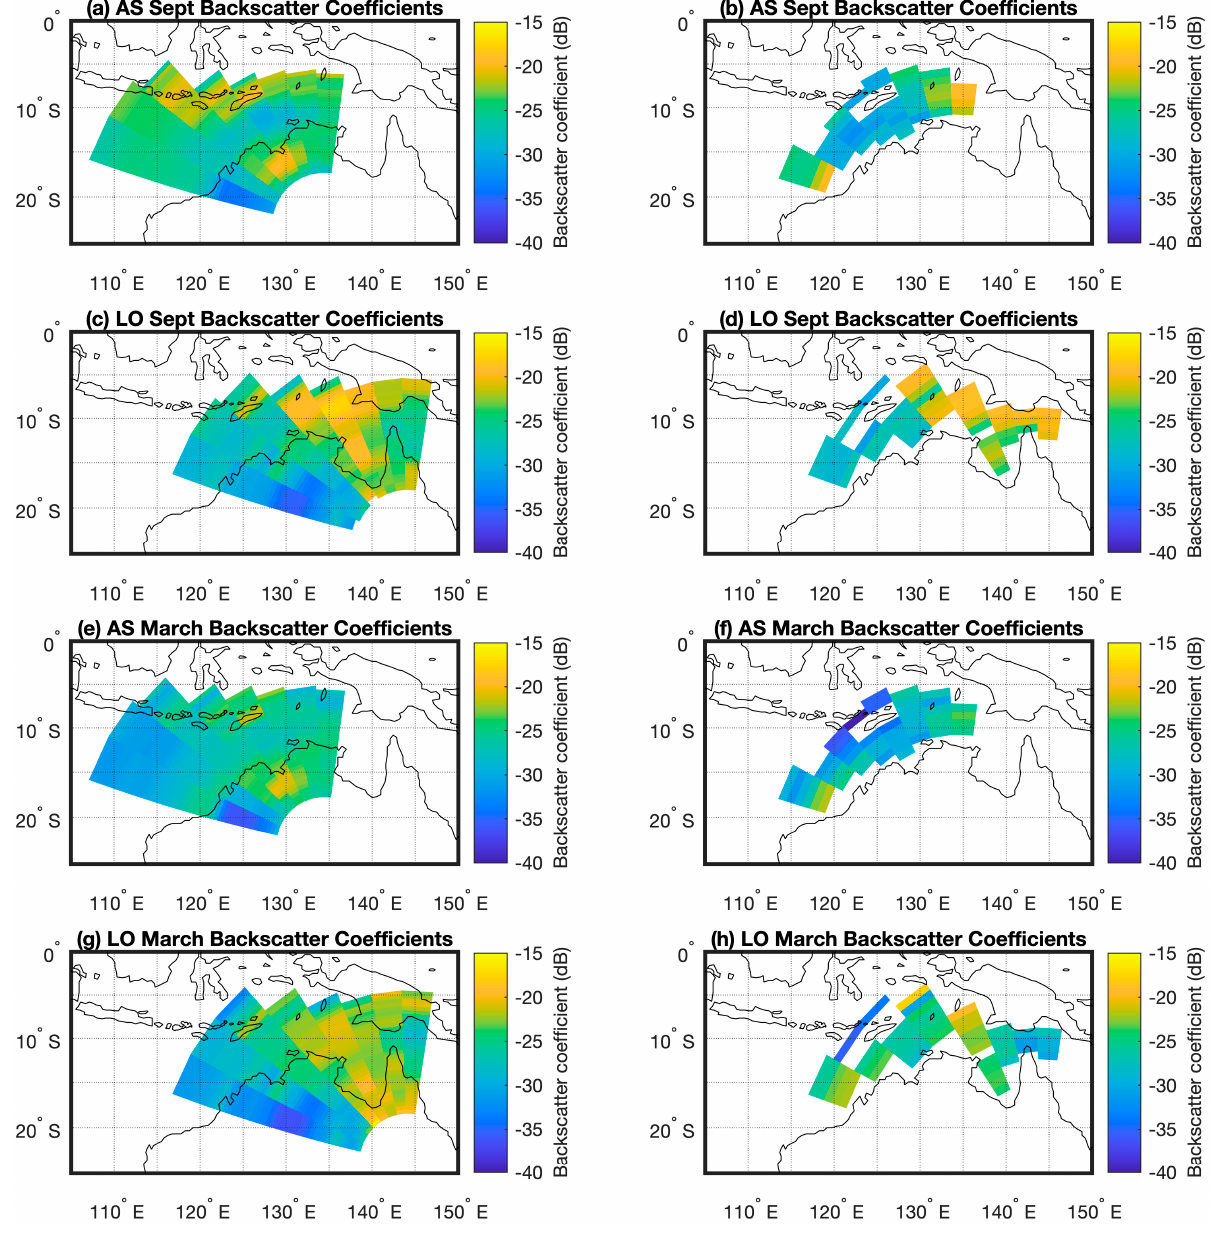
Figure 6. Monthly median daytime backscatter coefficients calculated using the backscatter ionogram method ( left ) and Barrick method ( right ). Range-azimuth cells that contain some land areas were excluded from the calculation for the Barrick method.